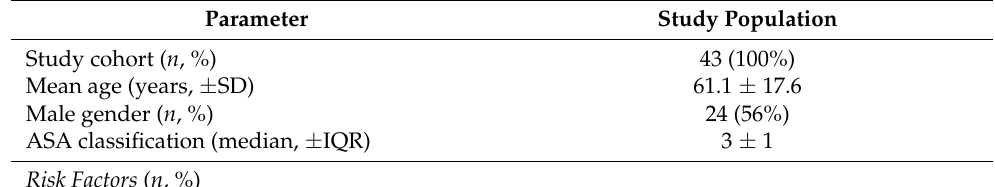
Table 1. Patient